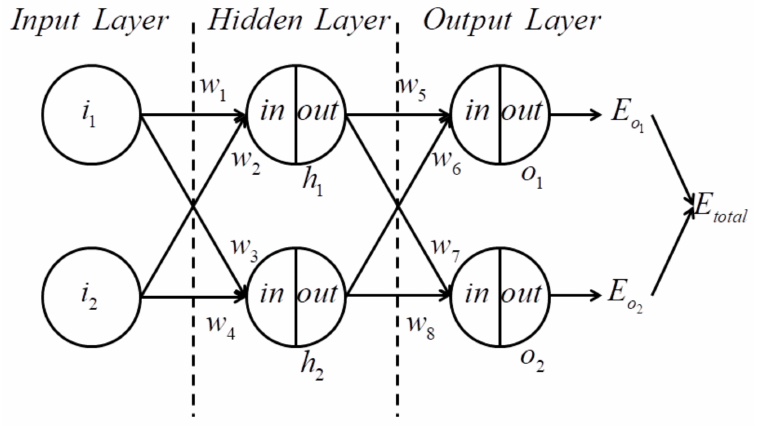
Figure 1. The profile of the three layer